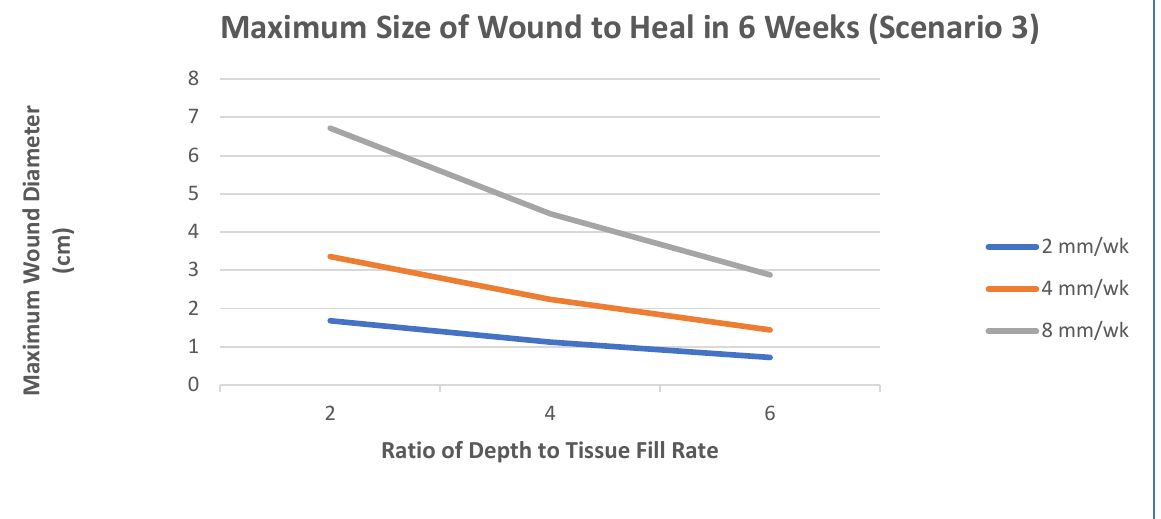
Figure 3. Graph representing the tissue fill rate needed if healing is to occur within the specified time for the given wound diameter. This represents scenario 2.